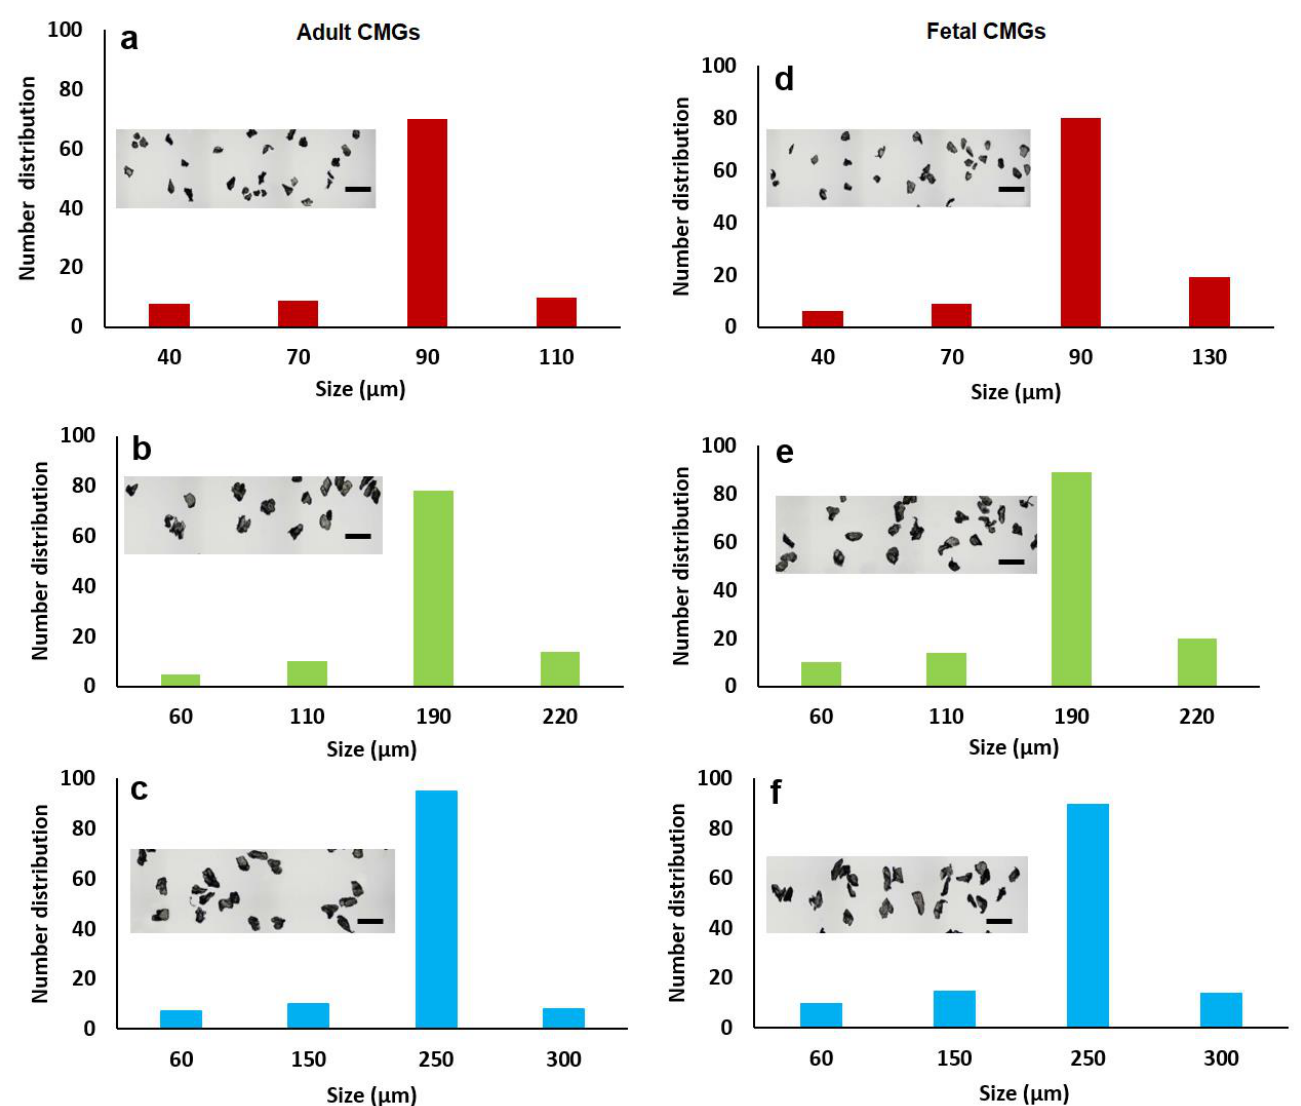
Figure 1. The size distribution of adult ( a – c ) and fetal ( d – f ) cartilage microgels (CMGs). The distributions ( a – c ) correspond to adult CMGs with average sizes of 90, 190, and 250 μm, respectively; distributions ( d – f ) correspond to fetal CMGs with average sizes of 90, 190, and 250 μm. The insets in the distributions are SEM images of the CMGs showing irregular shape of the microgels.